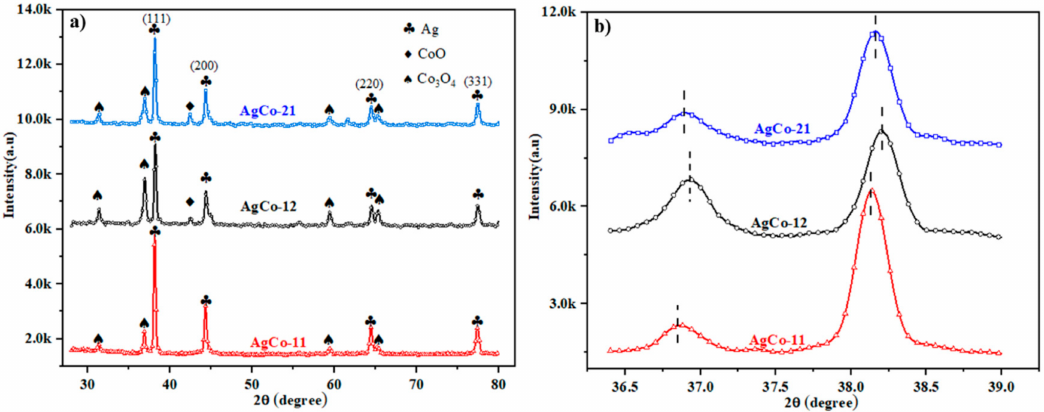
Figure 1. ( a ) XRD pattern of bimetallic Ag-Co synthesized using different modes of combustion synthesis; ( b ) selected 2 θ region of the XRD